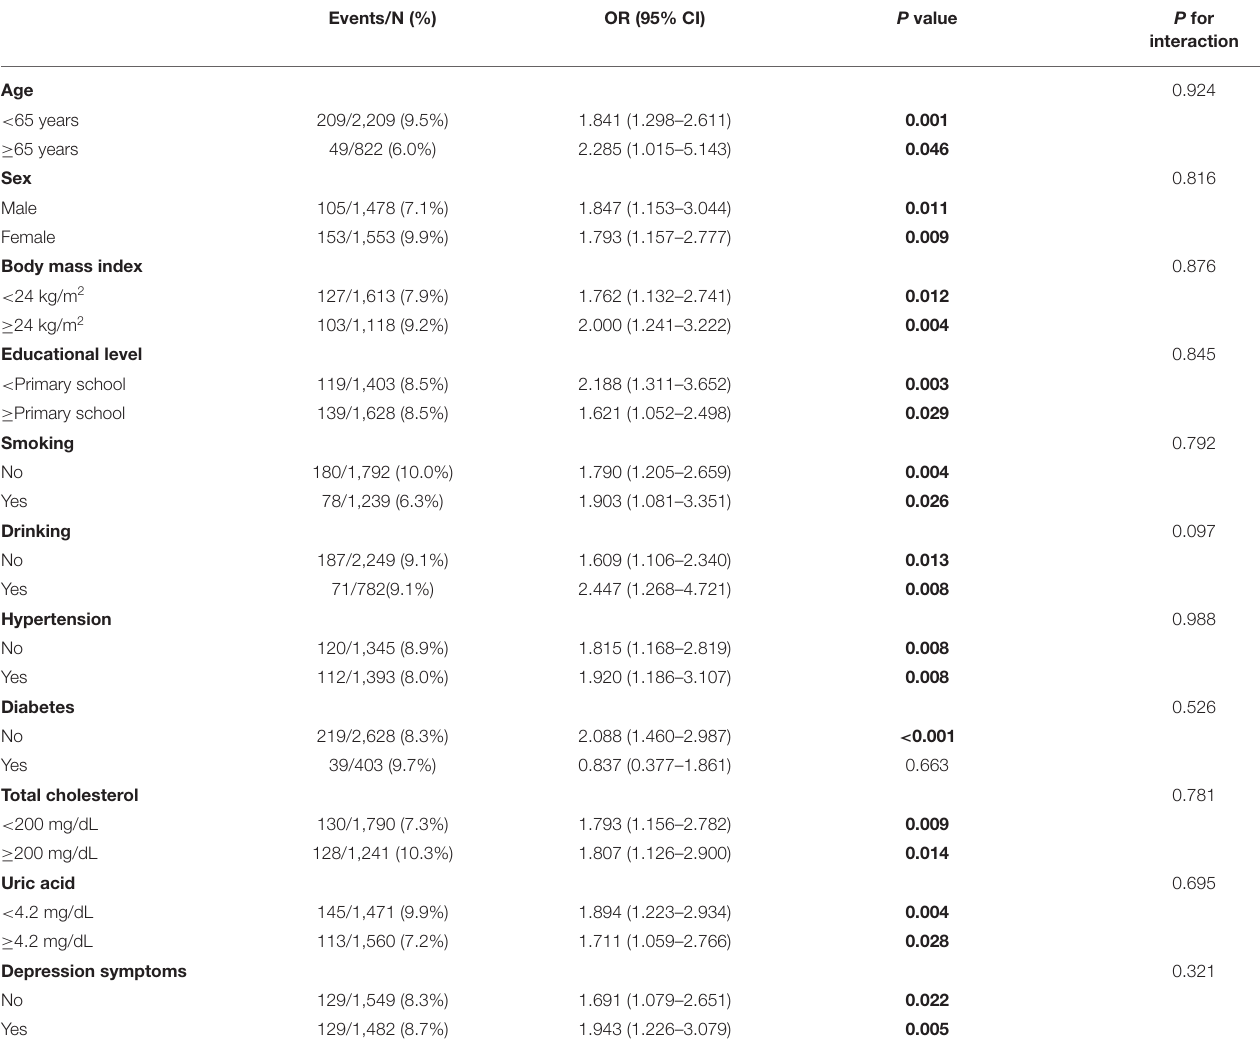
TABLE 4 | Effect of social isolation on the risk of rapid eGFR decline by subgroups. Events/N (%) OR (95% CI) P value P for